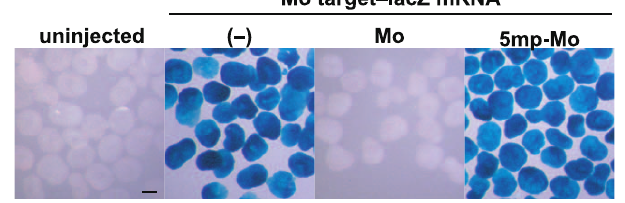
Figure 4. Specific Inhibition of Translation by CheFz1-Mo X-gal staining of embryos derived from eggs injected with a b - galactosidase reporter RNA bearing the CheFz1-Mo 5 9 UTR target sequence. Co-injection of CheFz1-Mo but not CheFz1-5mp-Mo com- pletely abolished b -galactosidase expression.